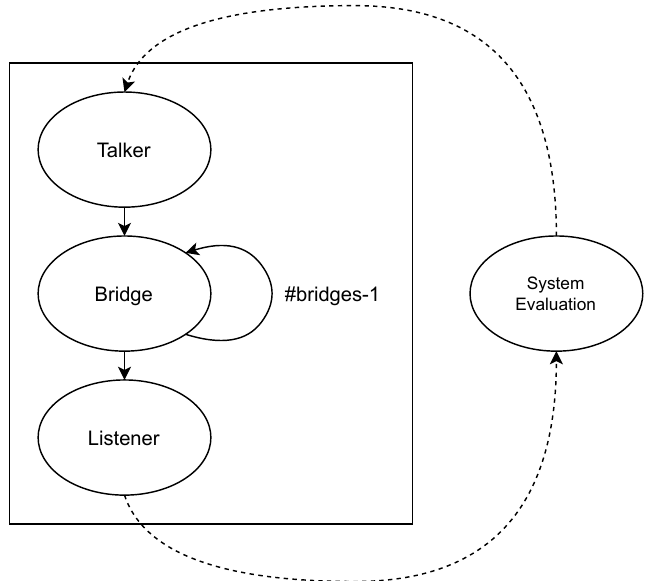
Figure 8. Blocks that constitute the path module.